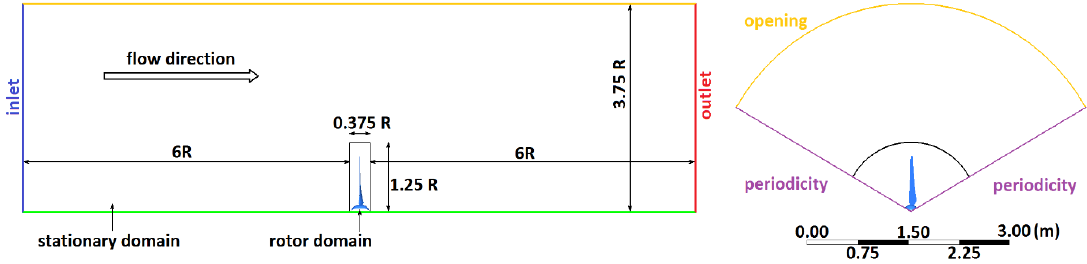
Figure 2. Side and front view of the analyzed problem geometry (elements are in scale).